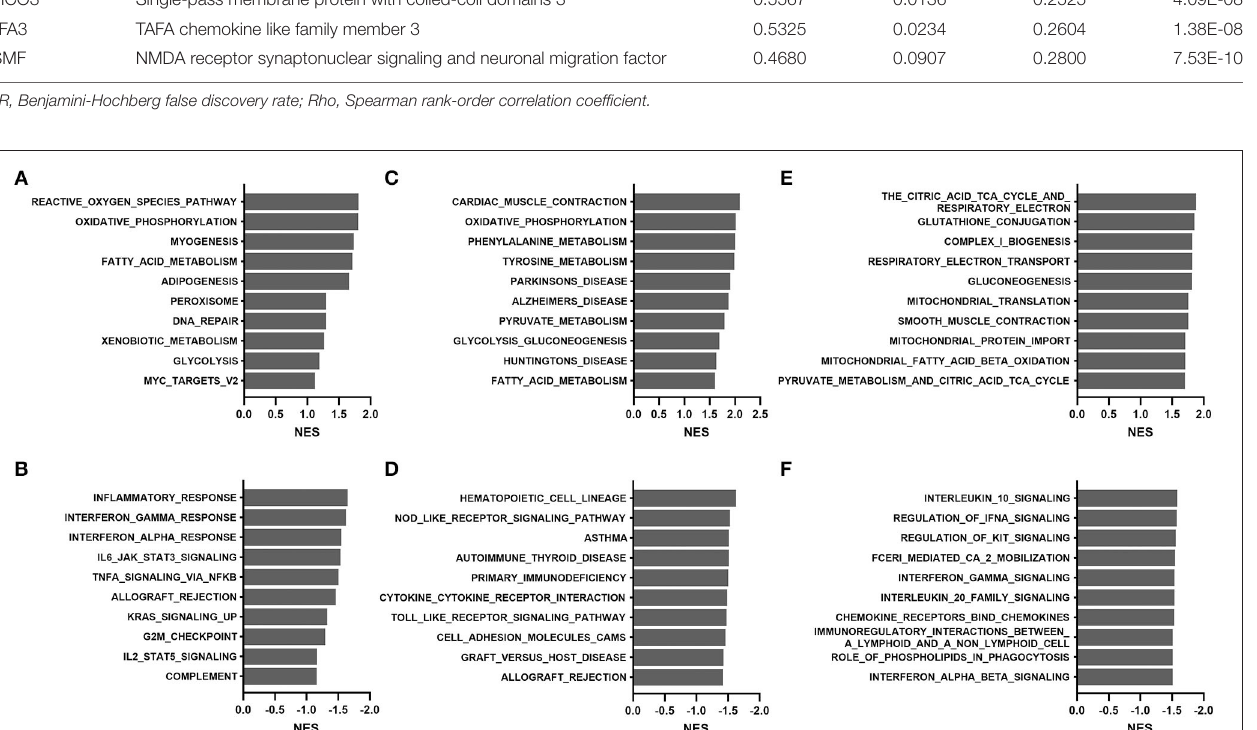
tyrosine metabolism, and fatty acid metabolism. Additionally, pathways related to mitochondrial function and muscle contraction were consistently enriched across